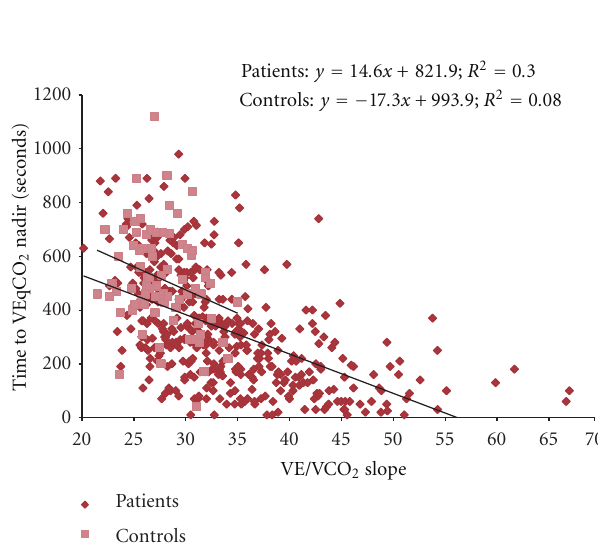
Figure 2: Relation between time to VEqCO 2 nadir and VE/VCO 2 slope in patients with CHF and controls.